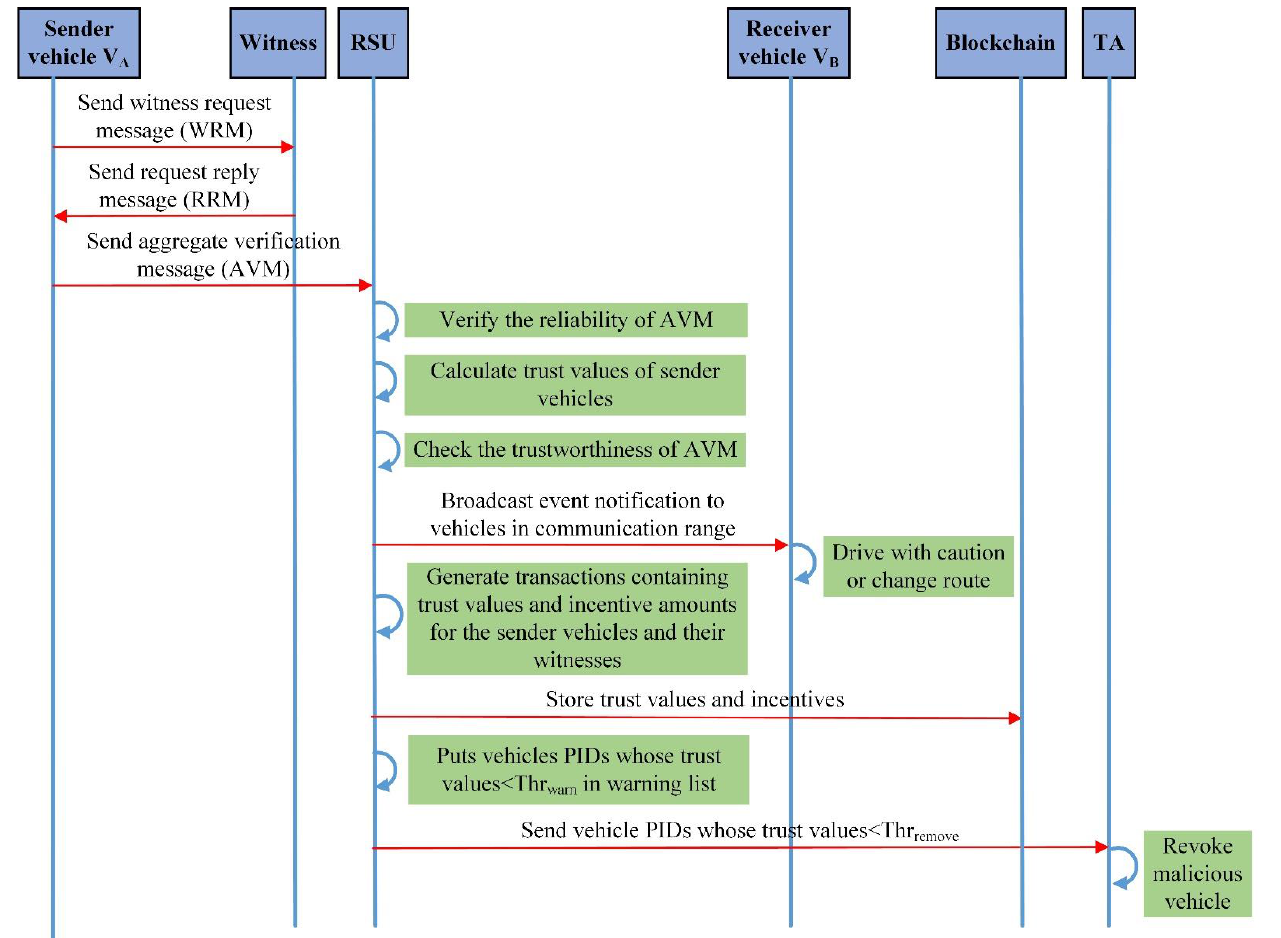
Figure 2. Validating the reliability and trustworthiness of reported road